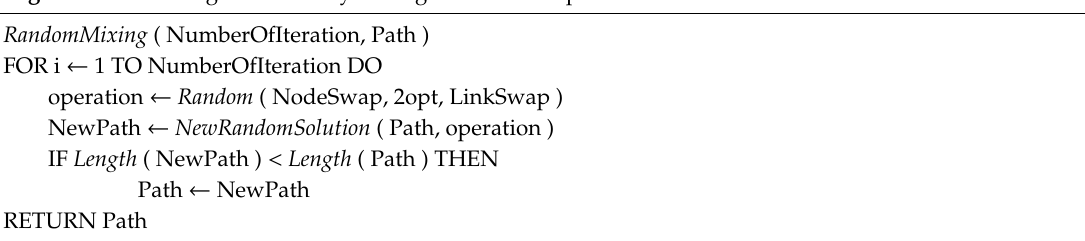
Algorithm 3: Finding a solution by mixing local search